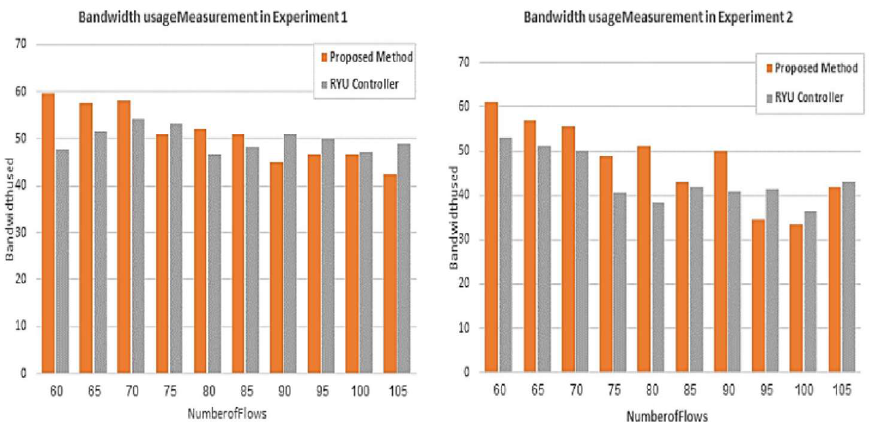
Figure 14. Comparison of Bandwidth Usage Between the Proposed Method and the Ryu Controller for the Two Types of Flows in Two Experiments.